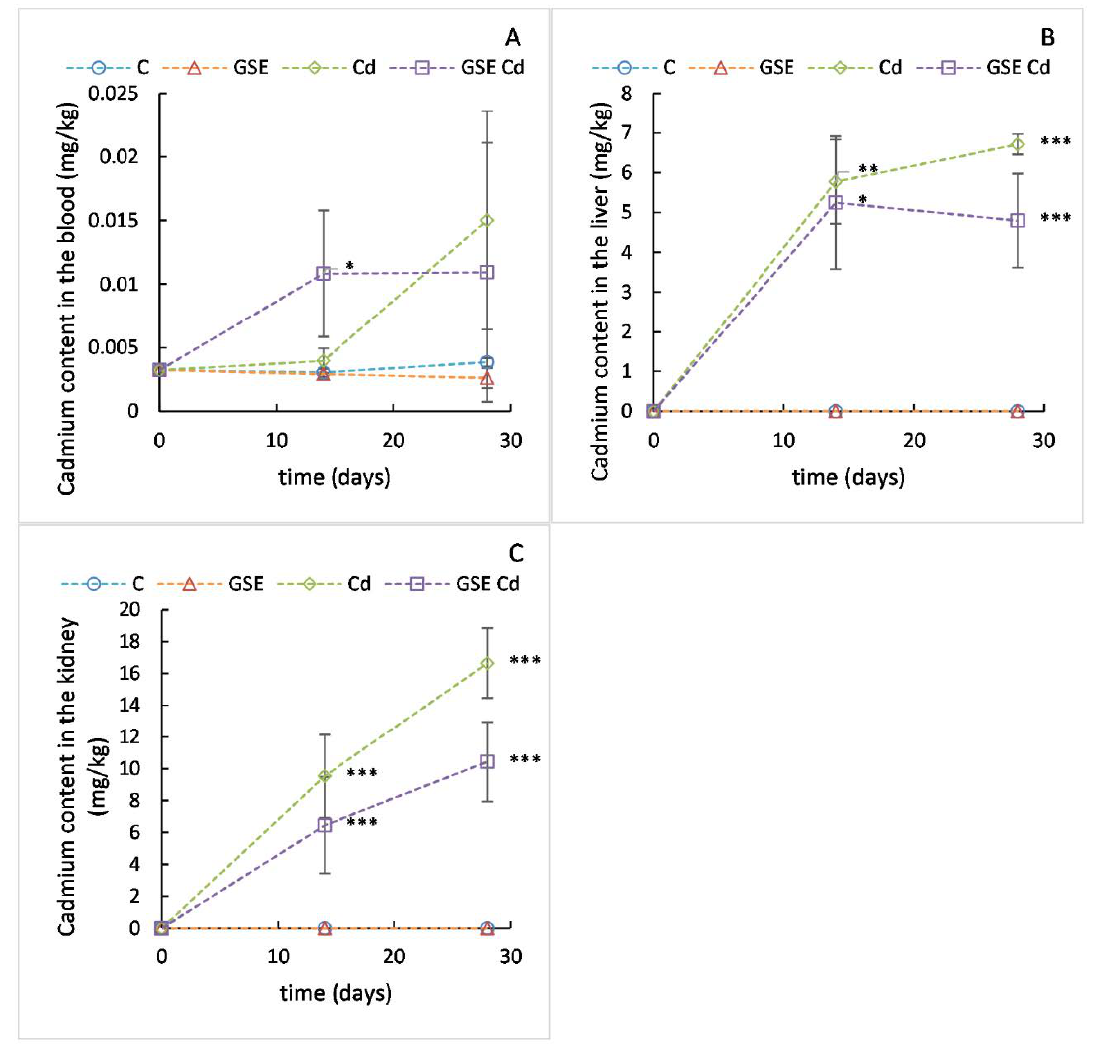
Figure 1. Cadmium content values in the blood ( A ), liver ( B ), and kidneys ( C ) for the control variant (blue line with circles), the variant with grape seed extract (GSE) addition (orange line with triangles), the variant with cadmium (Cd) addition (green line with diamonds), and the variant with both GSE and Cd additions (violet line with squares) on days 0, 14, and 28 of monitoring. Data are presented as means ± sd from three replicates. Data were analyzed by one-way ANOVA (each time point separately) and differences from control are marked: * indicates p ≤ 0.05, ** indicates p ≤ 0.01, *** indicates p ≤